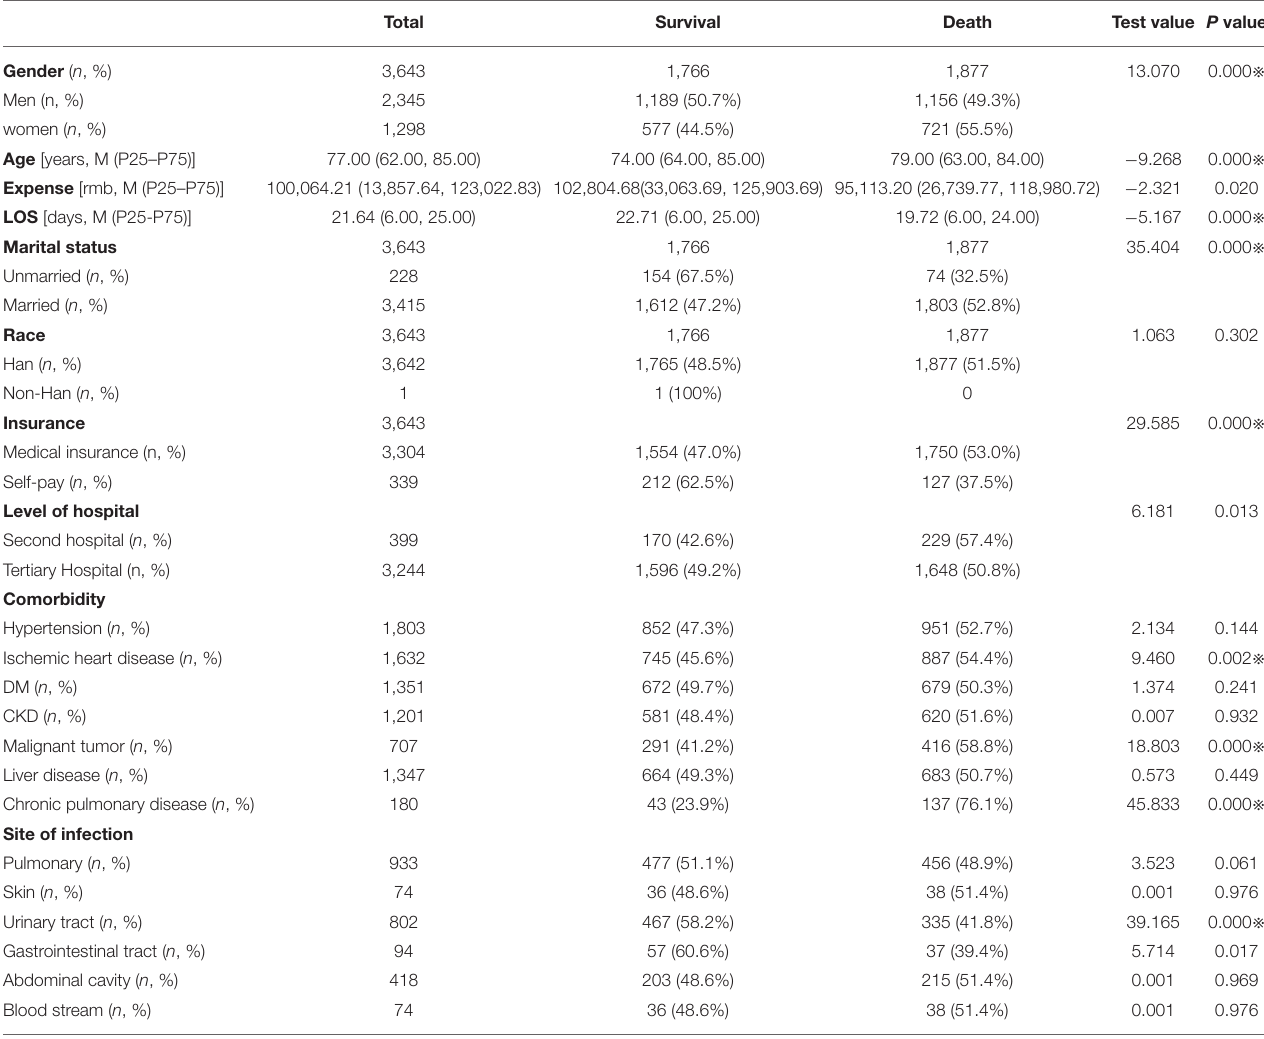
TABLE 4 | Risk factors for in-hospital mortality in patients with septic shock. Total Survival Death